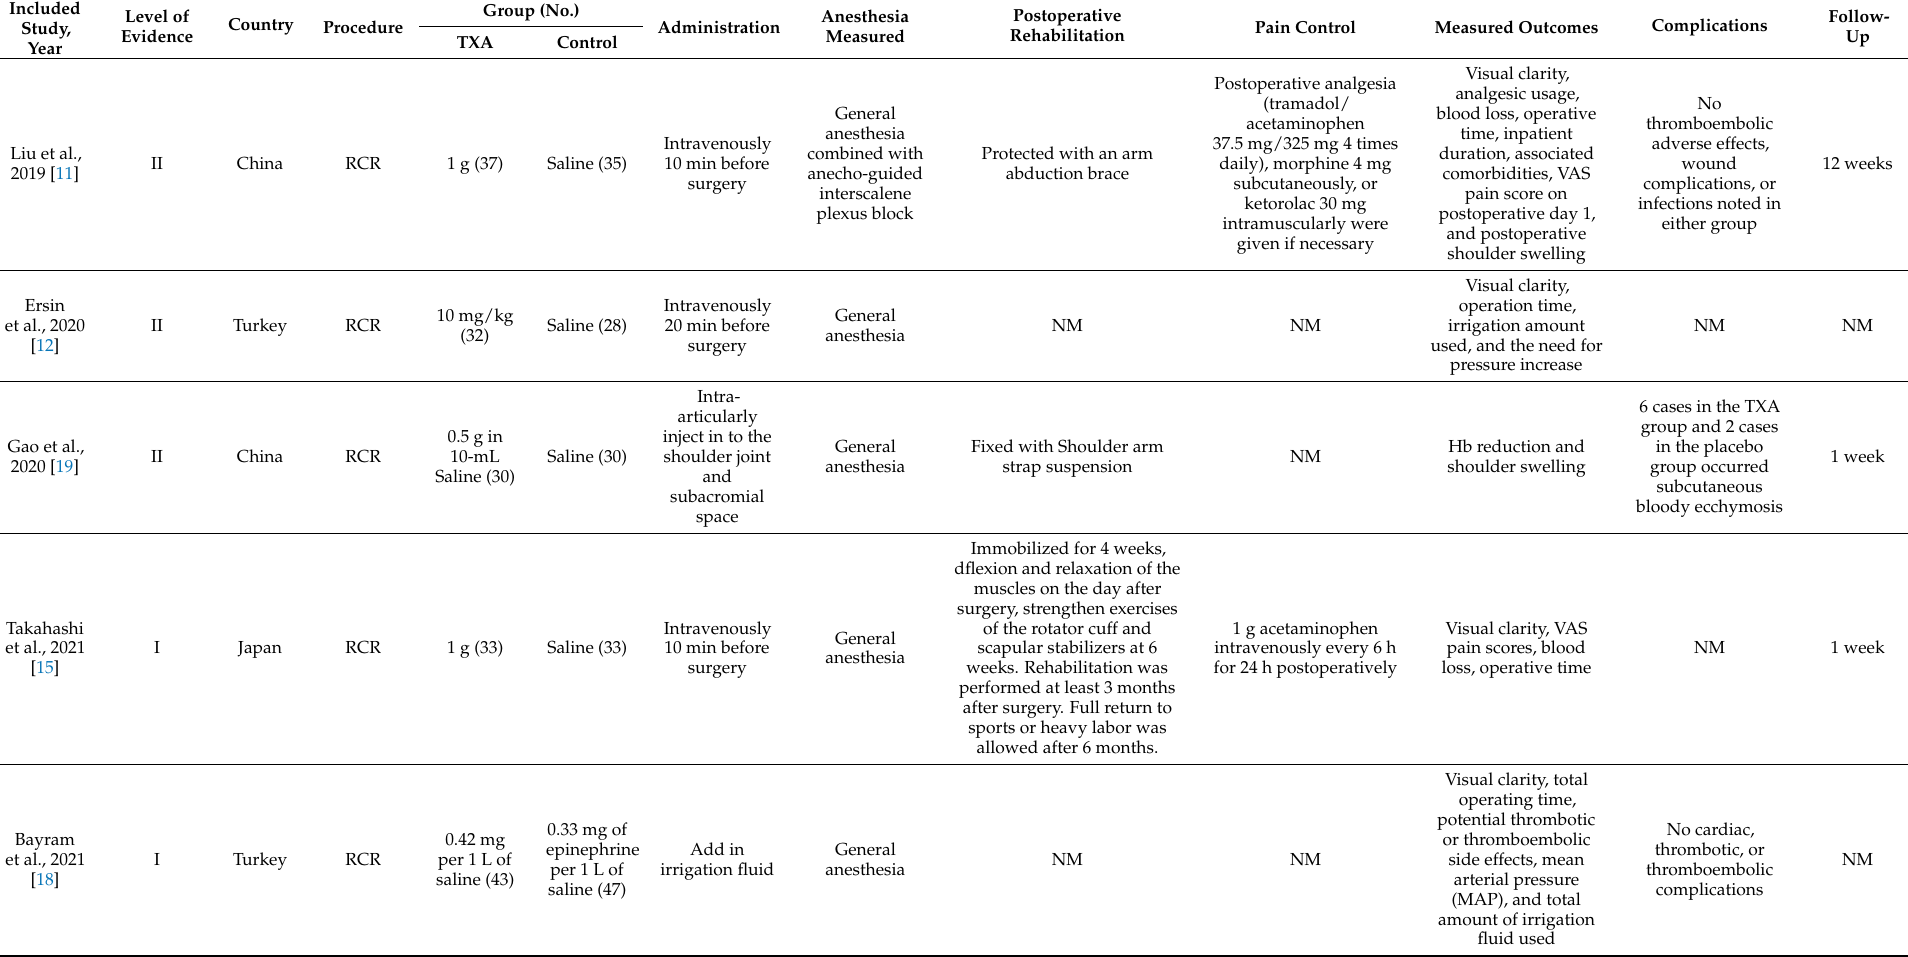
Table 1. Characteristics of the included